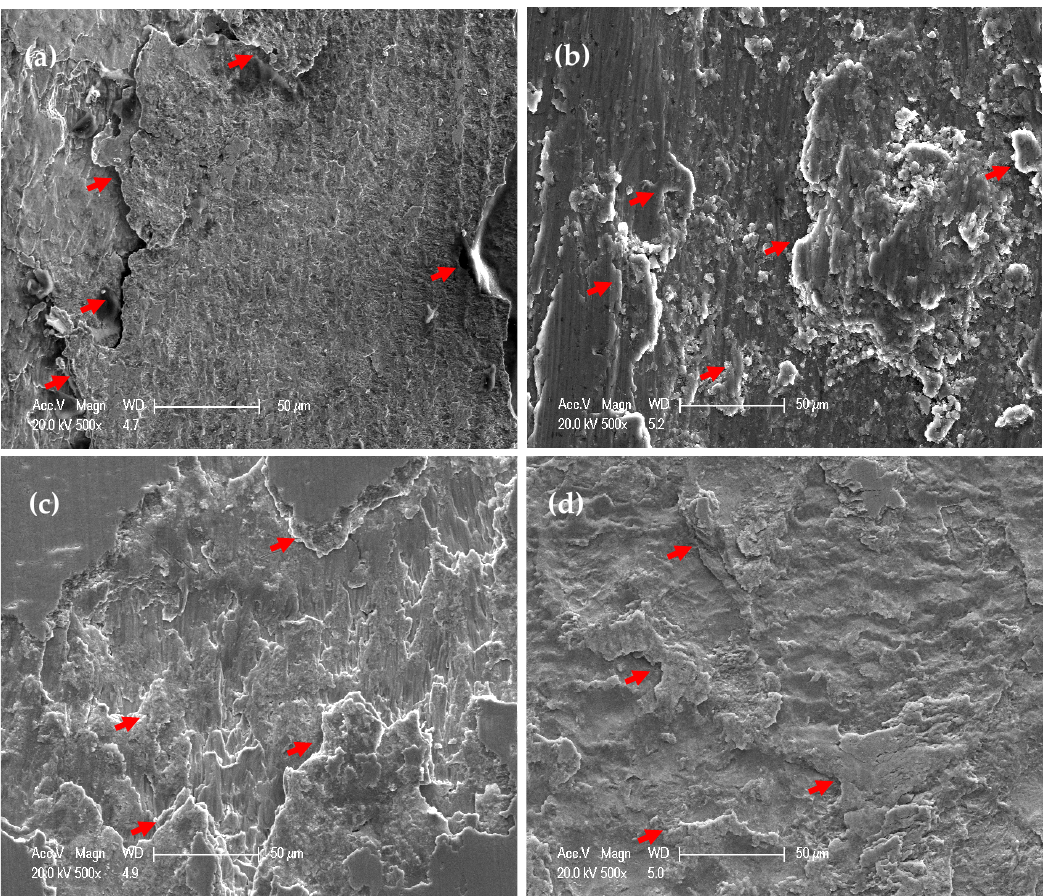
Figure 15. Worn surface morphology of the WC ball after sliding against ( a ) PM Al-20% Al 2 O 3 , ( b ) PM Al-20% SiC, ( c ) HPT-processed Al-20% Al 2 O 3 , and ( d ) HPT-processed Al-20% SiC samples under an applied load of 20 N and a sliding distance of 1260 m.